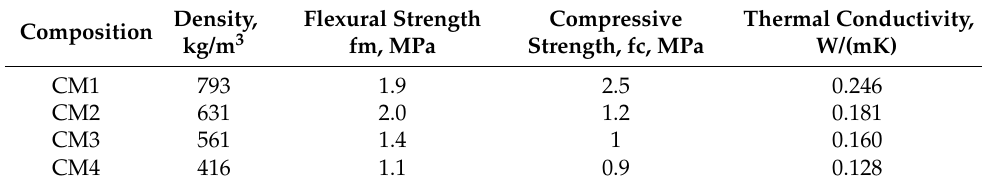
Table 1. Physical properties of EPS and gypsum samples for casting method. Density, Composition kg/m